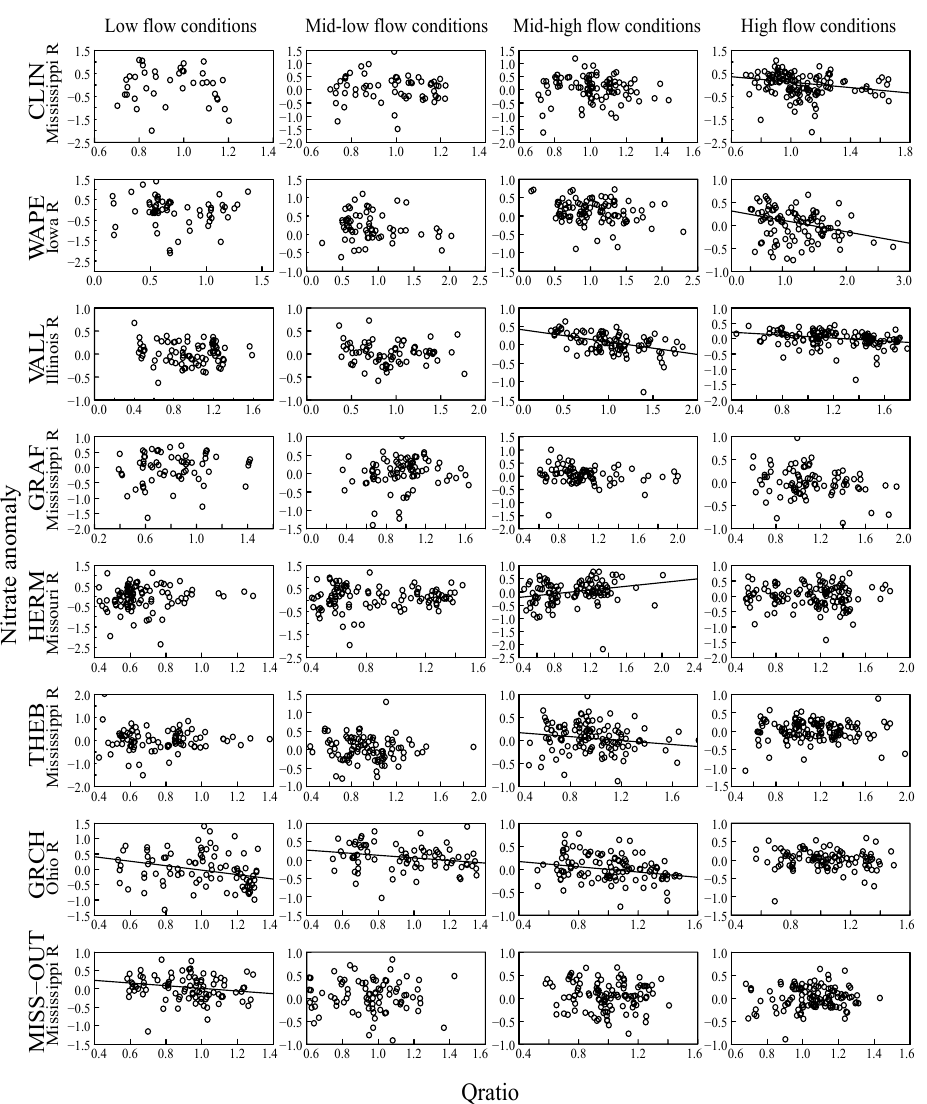
Fig. 4. Plots of nitrate anomaly versus Qratio, by site and contemporaneous flow class. Statistically significant relationships ( p ≤ 0.05) are denoted with a solid black line. Low flow conditions: < 25th percentile, mid-low flow conditions: > 25th and < 50th percentile, mid-high flow conditions: > 50th and < 75th percentile, and high flow conditions: > 75th percentile. Note horizontal and vertical axes are specific to each plot.